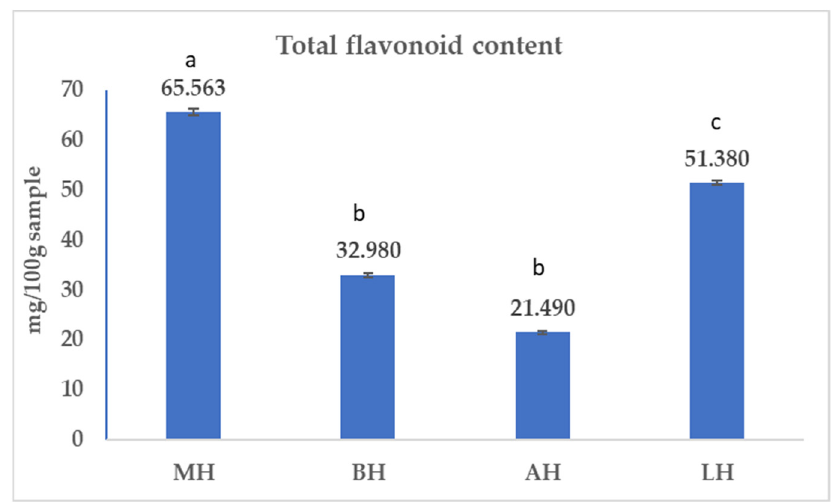
Figure 2. Total flavonoid content (TFC) of the honey sample. Mean values are expressed as mg/kg sample. The error bars indicate the standard deviation. Different letters among samples indicate significant differences ( p < 0.05) among values according to the t -test.